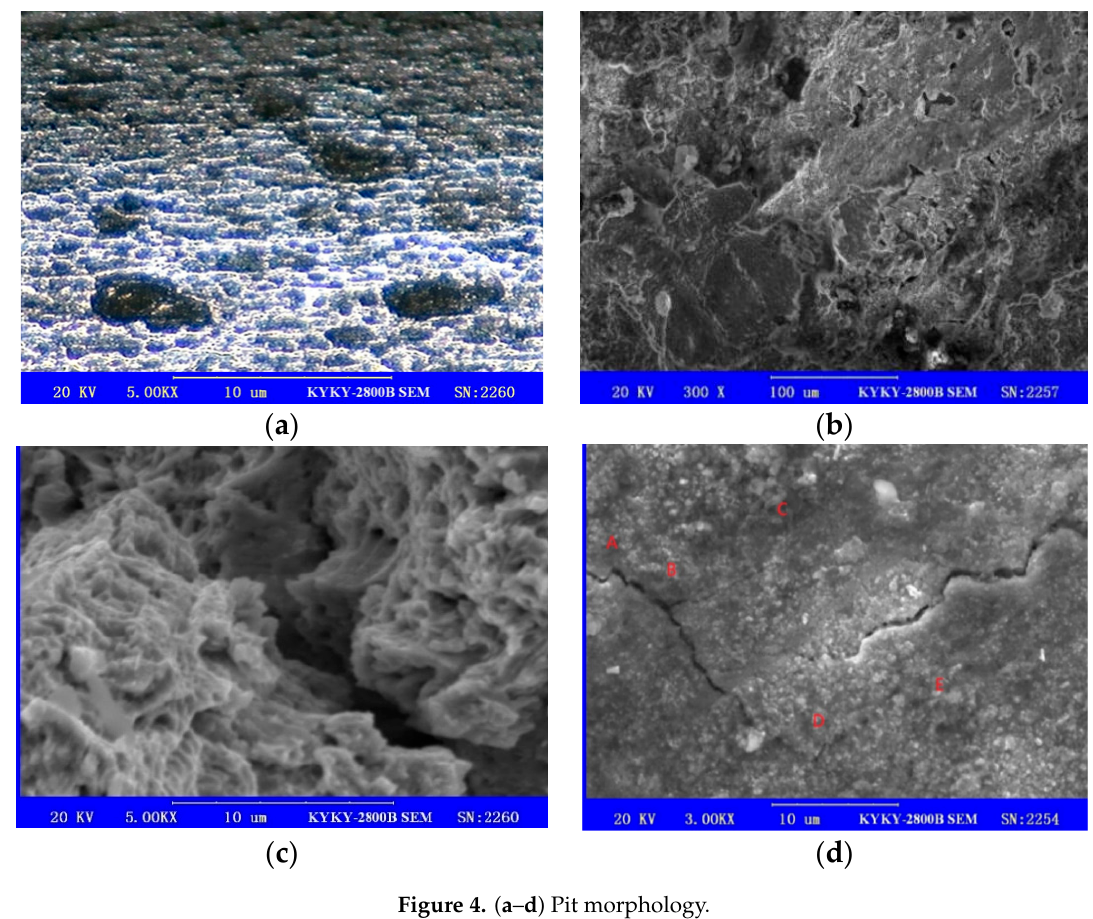
Figure 4. ( a – d ) Pit morphology.